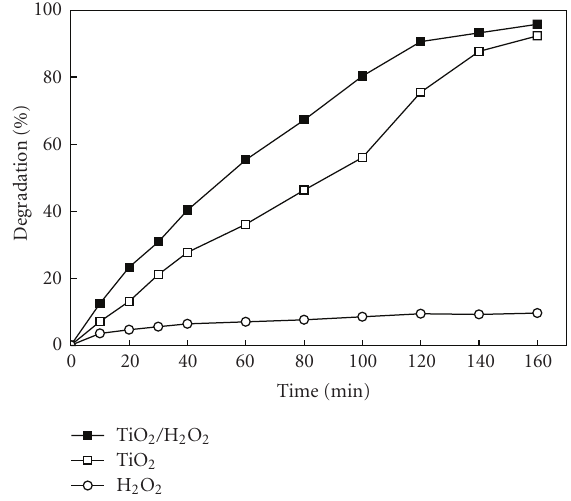
Figure 8: E ff ect of added H 2 O 2 on photodegradation. Table 3: E ff ect of catalyst load on